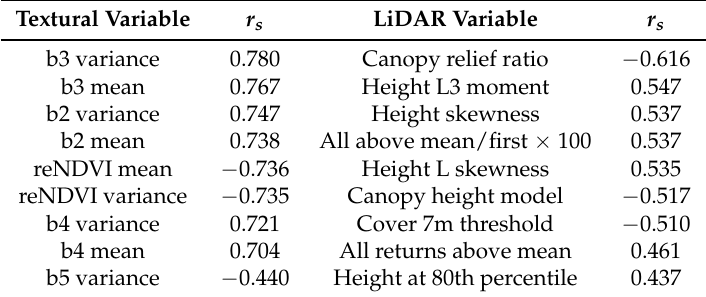
Table 2. Spearman correlation coefficient ( r s ): Remote sensing predictors versus nMDS-1 ordination scores. All correlations were statistically significant ( p < 0.0001).